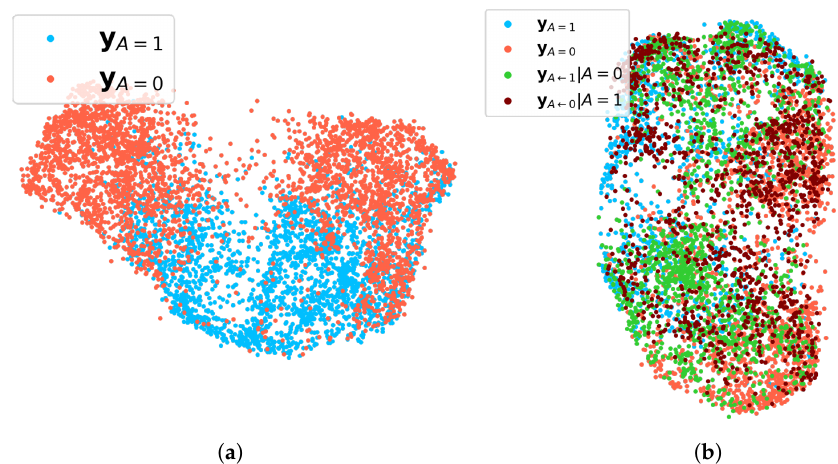
Figure 3. The UMAP visualization is applied for 29 binary facial attributes y without the sensitive attribute (gender). ( a ) Visualization for observed y in the training dataset. Facial attribute vectors of female ( y A = 0) and male ( y A = 1) are colored in orange and blue, respectively. ( b ) Visualization for observed y , and intervened y A ← a (cid:48) . The counterfactual attribute vectors of female and male are colored in green and dark red, respectively.